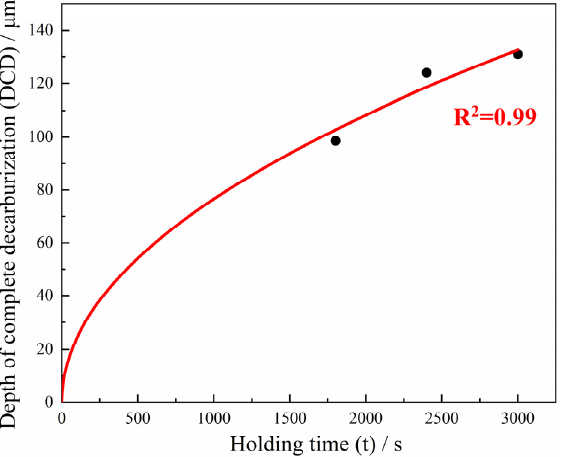
Figure 9. The variation law of complete decarburization depth at 900 °C h DCD = 2.42· √ t . (4)